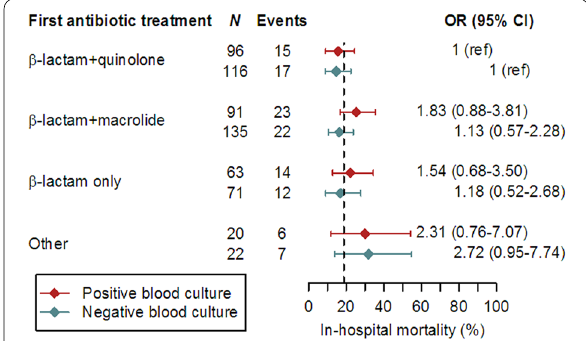
Fig. 2 Hospital mortality according to blood culture result and first antibiotic